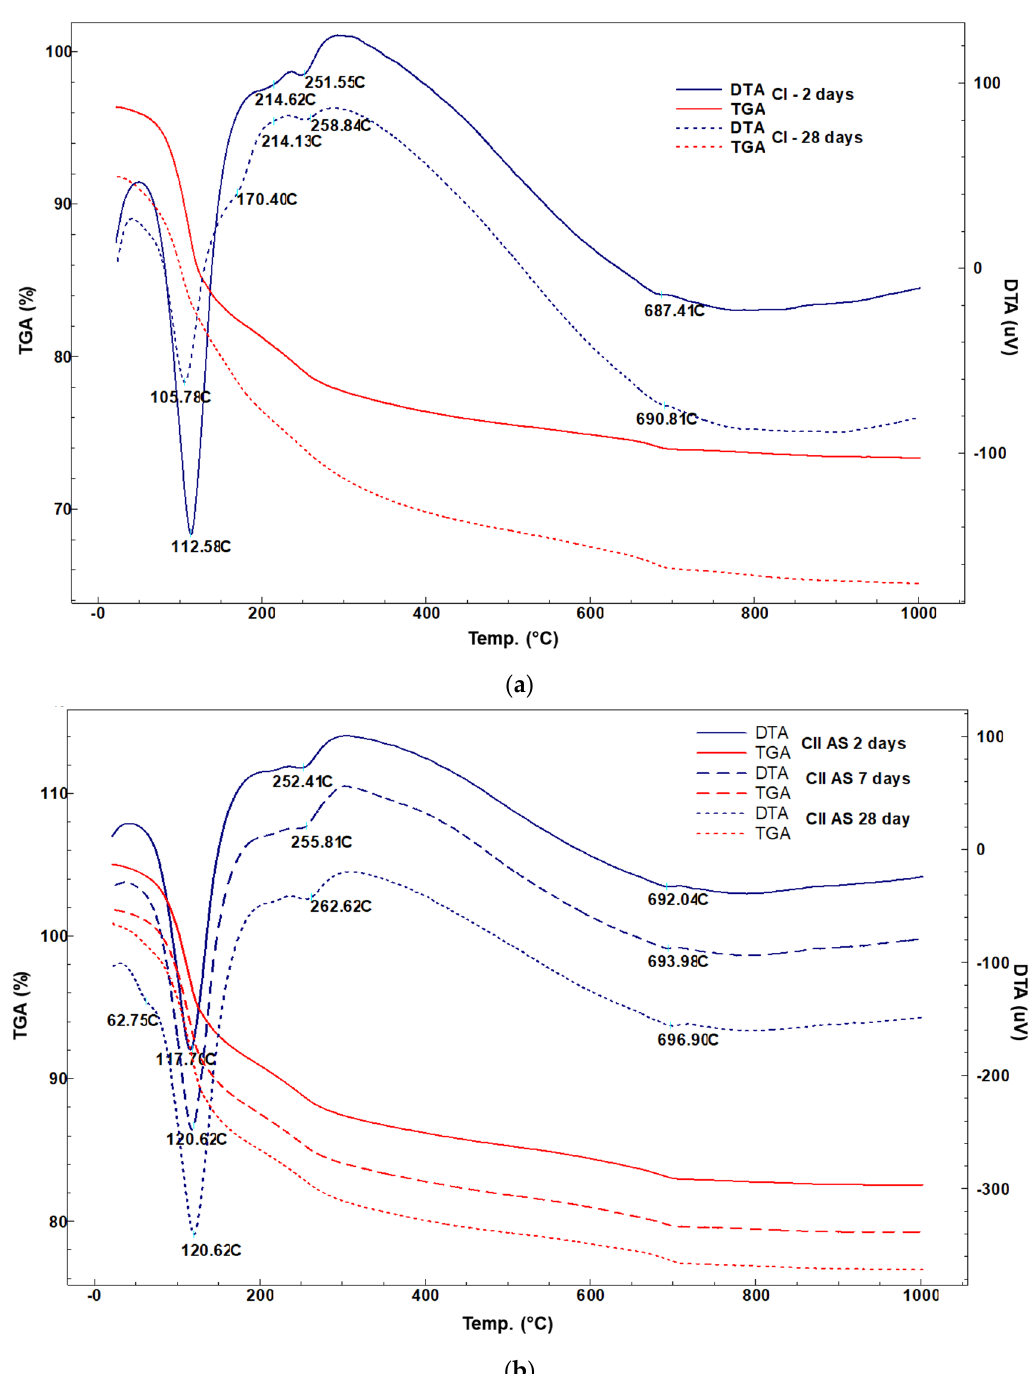
Figure 5. Thermal analysis of hydrated cement pastes for 2, 7 and 28-days: ( a ) CI, ( b ) CIIAS.